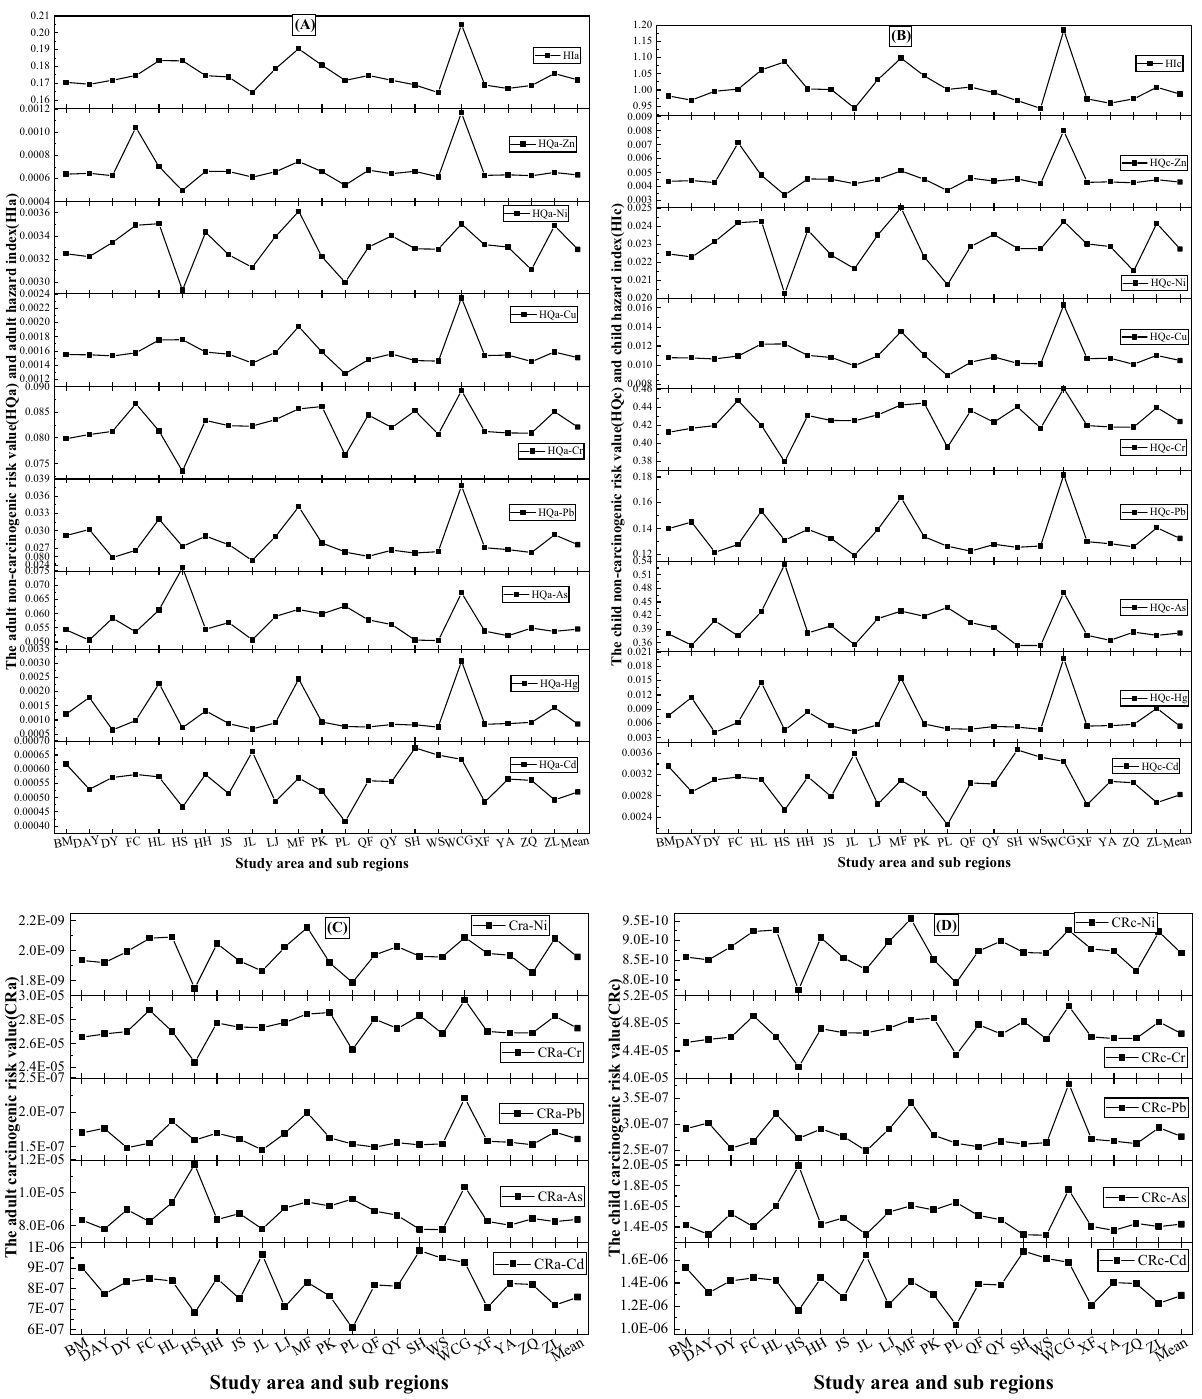
Figure 2. Health risks of HMS in the sub area of the study